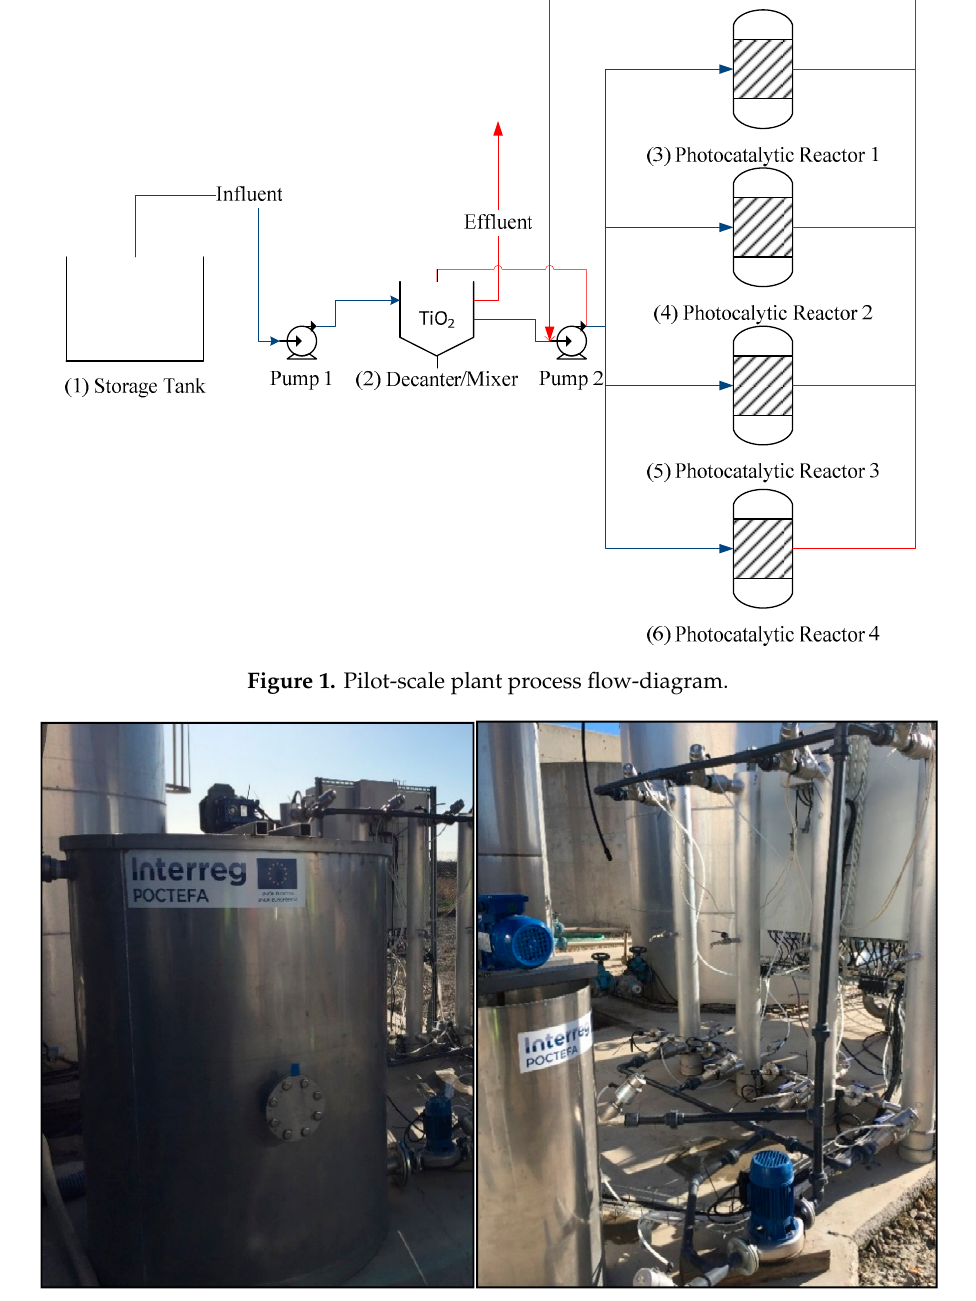
Figure 2. Pilot-scale plant process images.